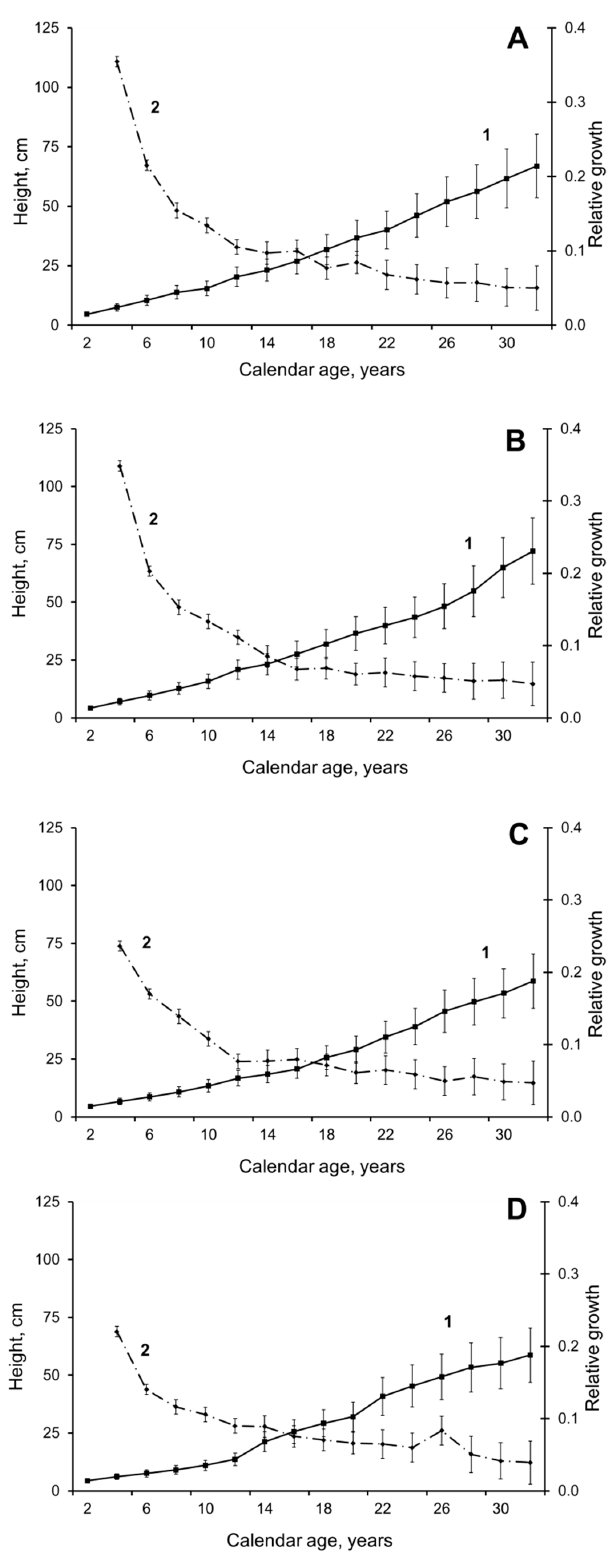
Figure 2. Growth dynamics in height (left scale) and relative growth (right scale) of the undergrowth of Siberian spruce ( Picea obovata Ledeb.) in ( A ) fir–spruce–moss forest, ( B ) spruce–moss forest, ( C ) pine–moss forest, and ( D ) larch–moss forest. Curves: 1, growth dynamics; 2, relative growth. In graphs: lines (mean), error bars (±SEM). Based on the rise and end of reproductive function, plant ontogenesis can be divided into stages (formation and development, change and death) according to their proportion in the organism [62]. Plant ontogeny stages have two peculiar classifications: one specifi- cally for trees [63]; the other, for perennial herbaceous plants initially [64] but subse- quently improved by other scientists [39,65–67], is now frequently used for a range of plant life, from trees to annuals, of varied ecological and geographical distribution [68,69]. To define the ontogeny phases of suppressed spruce undergrowth, we practiced Serebria- kov’s classification [39] and indicated the stages as juvenile ( j ), immature ( im ), and vir- ginile ( v ). 3. Results and Discussion There was insufficient regeneration of spruce under the canopy of the studied forest types. The greatest amount of small spruce undergrowth was found under the canopy of the FSMF and LMF, and the smallest under the SMF and PMF because of smaller crown density. Overall, there was a significant prevalence of small over large undergrowth: in the SMF, 25.6% of the small undergrowth passed into large undergrowth (i.e., it grew to a height ≥ 50 cm) compared to 22.0% in the PMF, 4.0% in the FSMF and 1.7% in the LMF. The spruce undergrowth was evenly distributed, 60–90%, in the trial plots. Most of the young trees grew in the moss cover and some spruce were found on micro-relief sites (micro hills) formed from decaying wood. Most of the spruce undergrowth formed xylorhizomes: FSMF, 90.0%; SMF, 80.0%; PMF, 87.0%; and LMF, 77.0%. Xylorhizome formation in spruce is similar to that in fir [34] and linden [48]. (The xylorhizome formation scheme was introduced earlier [33]). By age 20, 96% of the spruce formed at least one adventitious root on the buried part of the stem. The xylorhizome formation resulted in a change to the relative size of the above-ground part of the plant (height above soil level) and its absolute length (including the buried parts). Depending on forest type, this ratio varied on average from 41 to 75%, and the height of individual spruce was only 22% of the total height (above soil level plus buried part) (Table 2). Spruce growth dynamics changed due to a large amount of suppressed undergrowth with xylorhizomes (Figure 2). The highest, but not statistically valid, increases in height and relative growth rates for undergrowth were found in the SMF and PMF, with minimal increases in the FSMF or LMF. Most spruce grew more than 50 cm and developed into large undergrowth only at age 32–33. In contrast, depending on the amount of light, the height of young Norway spruce ( Picea abies (L.) H. Karst.) by age 35 may vary between 1 and 8 m [70]. According to other data, Norway spruce seedlings take 30–60 years to grow